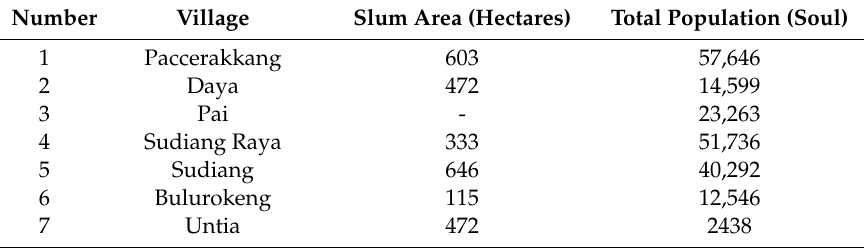
Table 2. Distribution of slums, population, and density of Biringkanaya District.